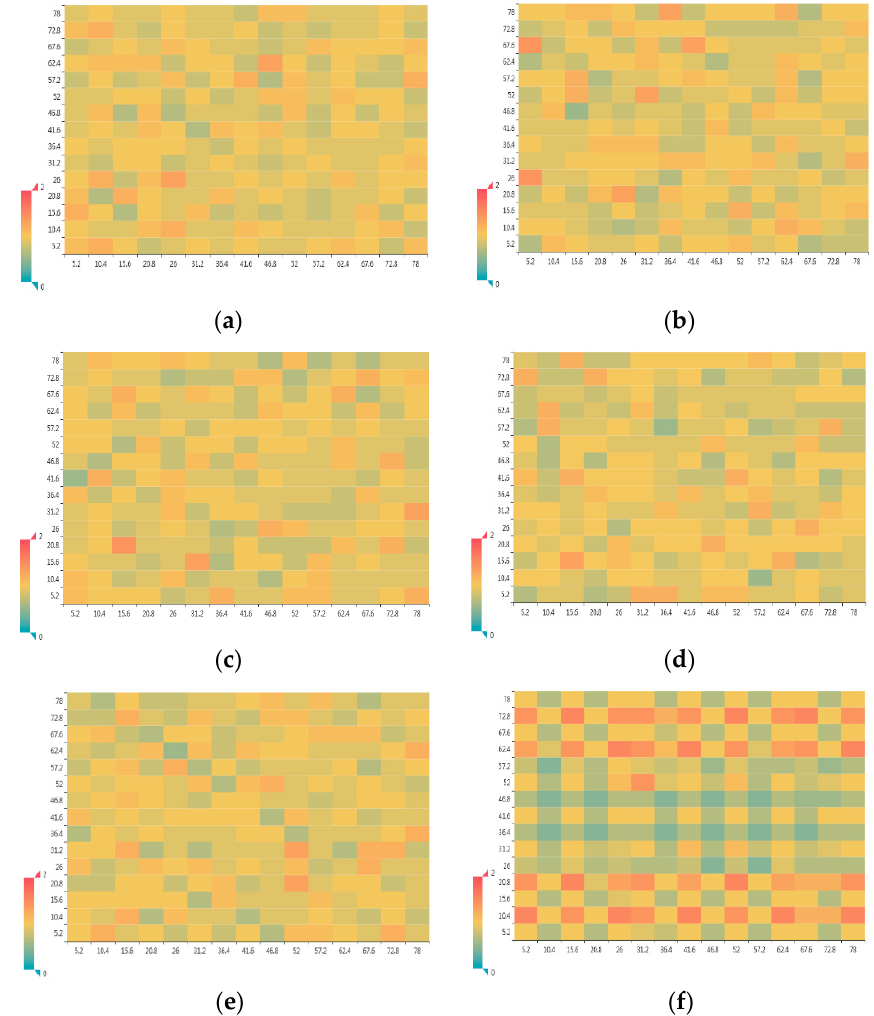
Figure 6. Atomic number density distribution after melting and cooling at different heating temperatures: ( a ) melting at 2800 K and solidification, ( b ) melting at 2700 K and solidification, ( c ) melting at 2600 K and solidification, ( d ) melting at 2500 K and solidification, ( e ) melting at 2400 K and solidification, ( f ) melting at 2300 K and solidification.